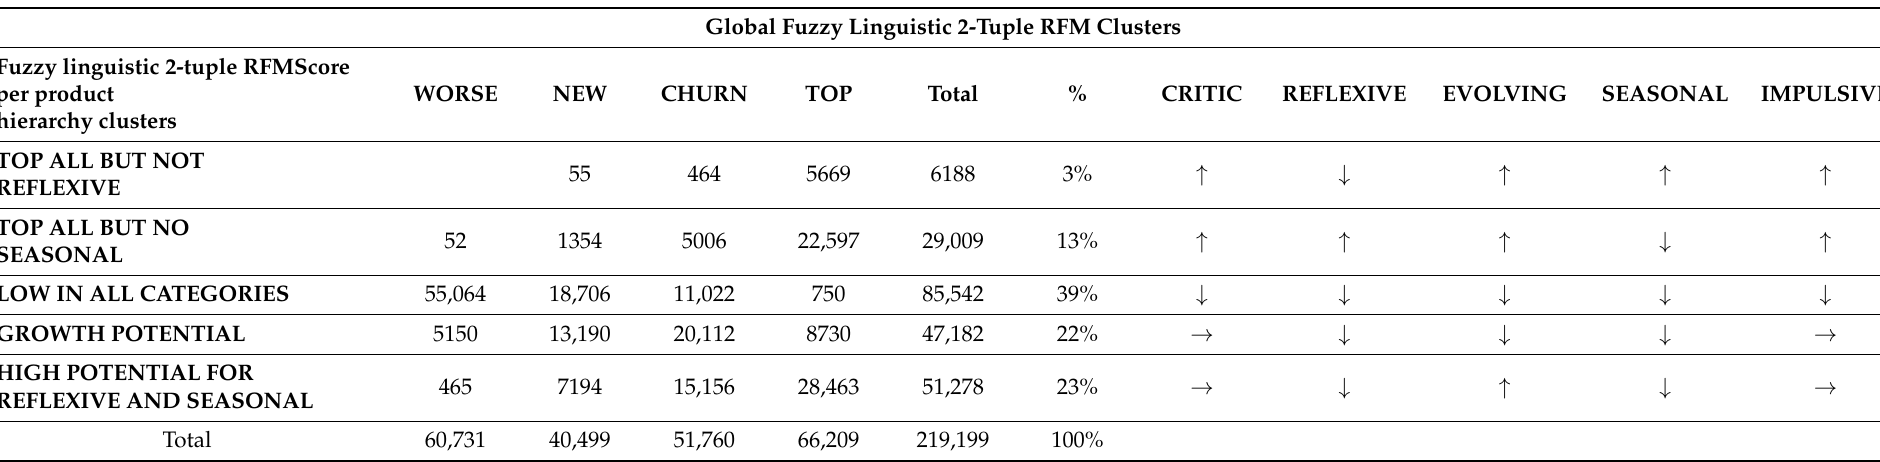
Table 6. Cross table to enrich 2-tuple RFMScore per product hierarchy cluster with the global fuzzy RFM clusters.